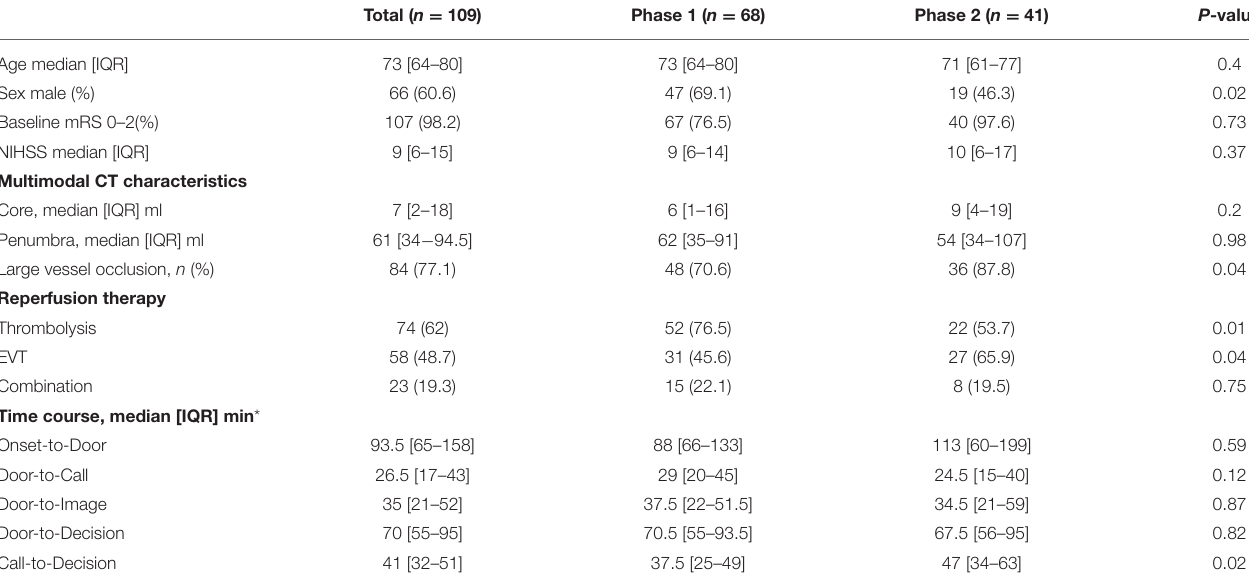
TABLE 3 | Clinico-radiological characteristics and workflow metrics of patients who underwent reperfusion